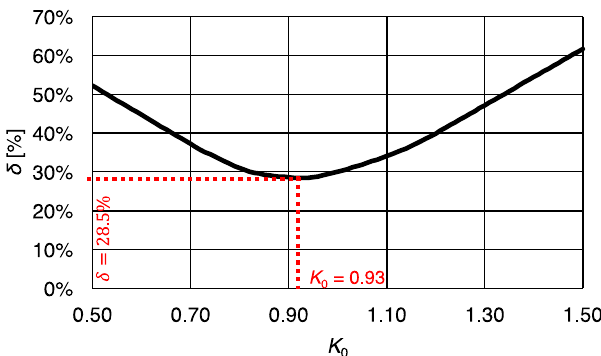
Figure 14. Mean relative error δ for K 0 parameter using formula included in Regulation (Journal of Laws 2000 No. 63, item 735) Equation (10).